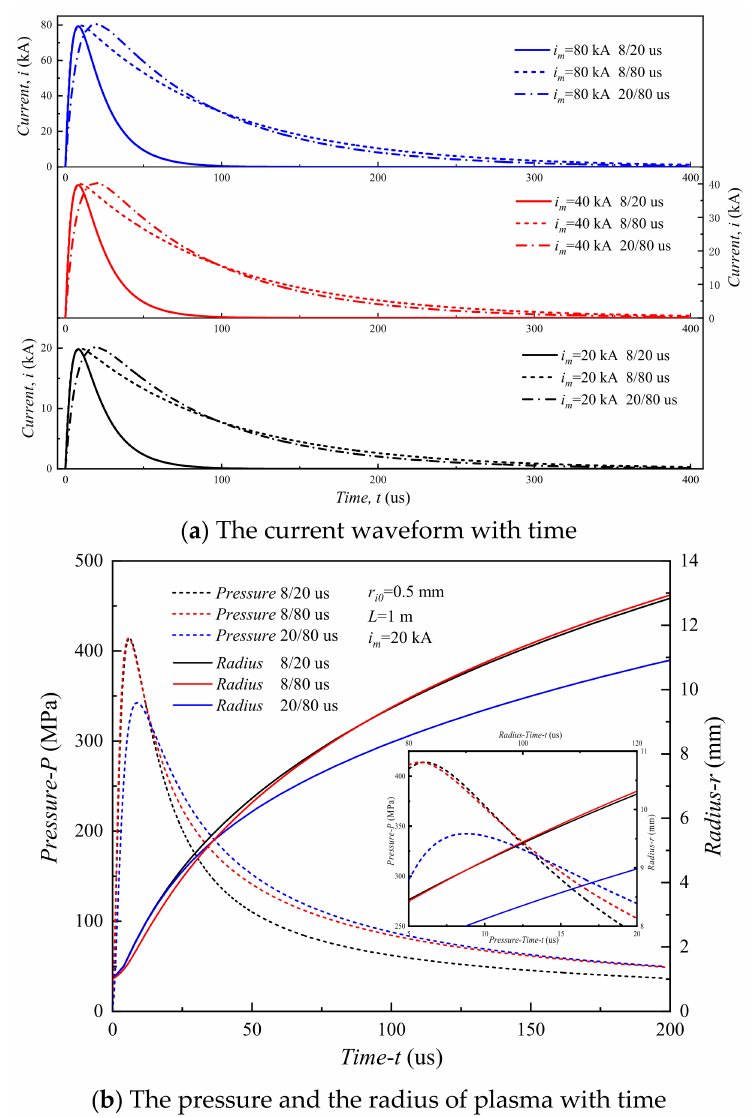
Figure 11. Properties of plasma channel